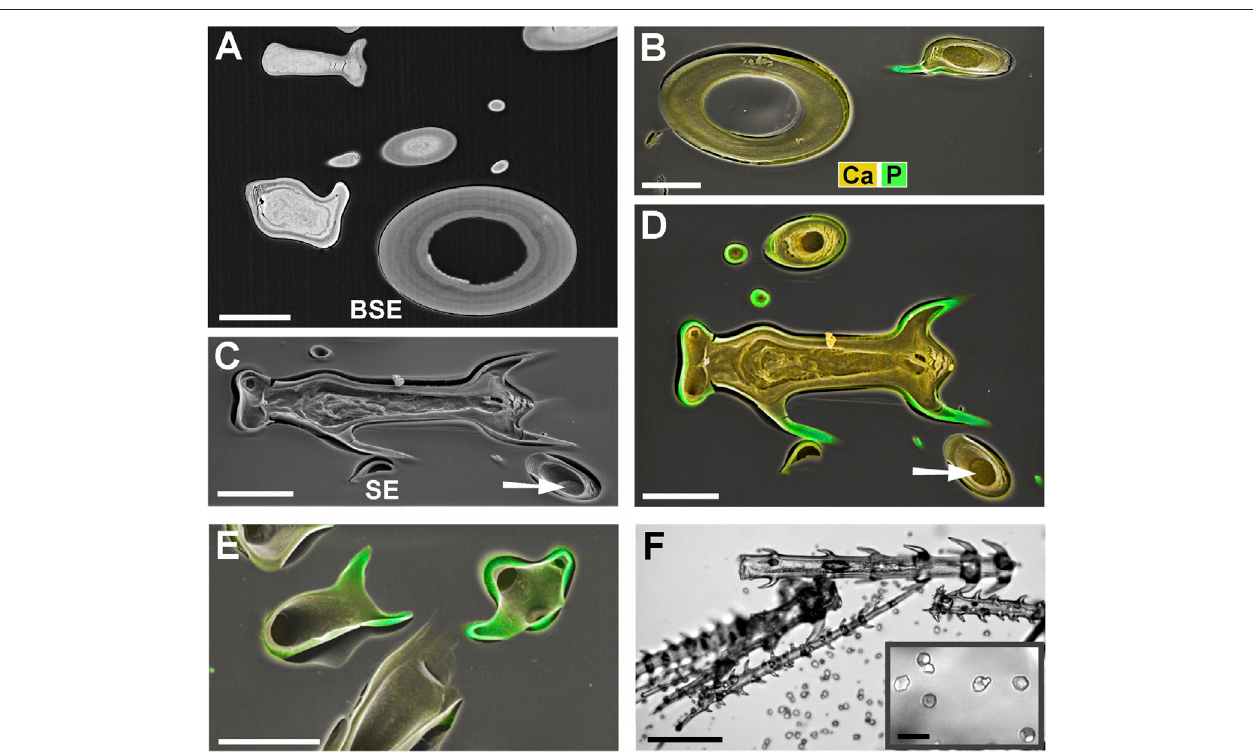
FIGURE 9 | SEM block-face images and LM image of Loasa pallida trichomes illustrating solubility of biominerals in water. (A) BSE image of sections through glochidiatetrichomesandastinginghairwithoutH 2 Otreatment (control).Highmineralconcentrationsappear bright. (B – E) CombinedSEandelement-mappingimages of embedded trichomes after 12 min in water (at 29 ° C) (B – D) , and after 2 h in water (E) . (B – D) After 12 min H 2 O treatment, Ca-carbonate of the core is dissolved to a depth of ca 10 µm. Remaining Ca-carbonate can be seen at the bottom of the holes (arrow). Ca-phosphate in the barb tips is still present (green). Cell walls still contain Ca (yellow) and show slight shrinkage. (C) SE image of tilted sample provides a better impression of depth of voids after mineral dissolution. (E) After 2 h of H 2 O treatment, the calcium carbonate core has been dissolved completely. The regular cell walls still exist, but have lost most of their mineral content; Calcium phosphate is still present in barb tips and adjacent outer layers (green). (F) LM image of a batch of isolated glochidiate trichomes in water after 45 min of immersion. The amorphous CaCO 3 inthetrichomesdissolvesandcalcitecrystalsstartgrowinginthevicinityofdensetrichomebatches.Theinsetshowsgrowingcrystalsindetail.Scalebars:A-E (cid:1) 30 μ m; F (cid:1) 100 μ m; inset in F (cid:1) 20 µm.